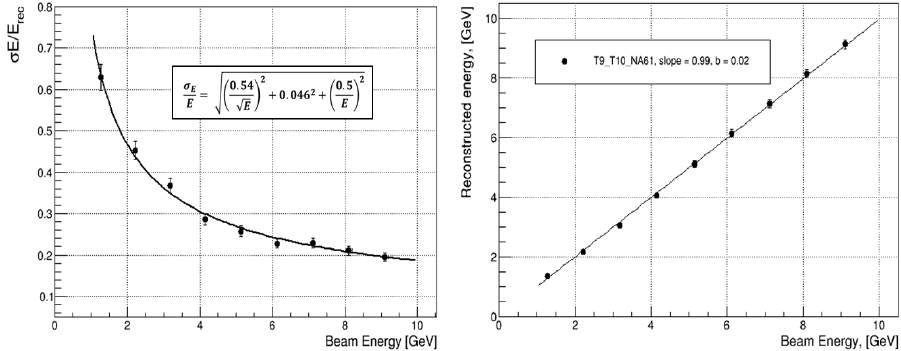
Figure 4. Supermodule energy resolution (left) and linearity (right) vs proton beam energy